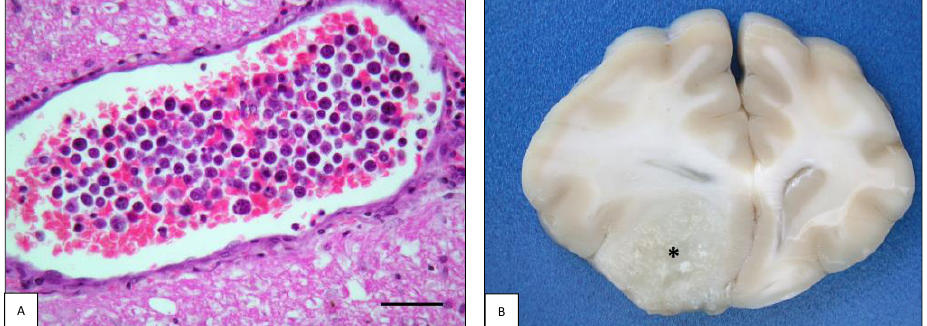
Figure 3. Intracranial lymphoma. ( A ) Intravascular lymphoma. Case #30. Dog brain section with blood vessel lumen filled with large neoplastic cells (H&E, bar = 100 µm). ( B ) Meningeal lymphoma. Case #58. Cat brain section with a focally extensive meningeal lymphoma (asterisk) accompanied by intraparenchymal invasion and perilesional edema causing enlargement of the right hemisphere and left shifting of the midline structures.